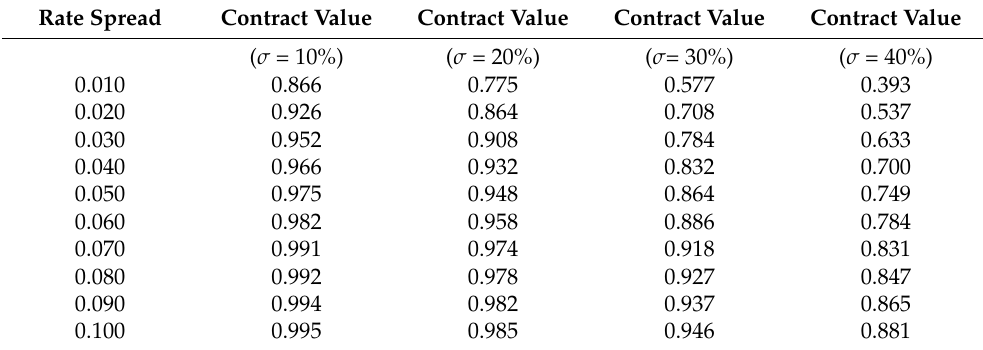
Table 1. Rate spread, risk and contract value.